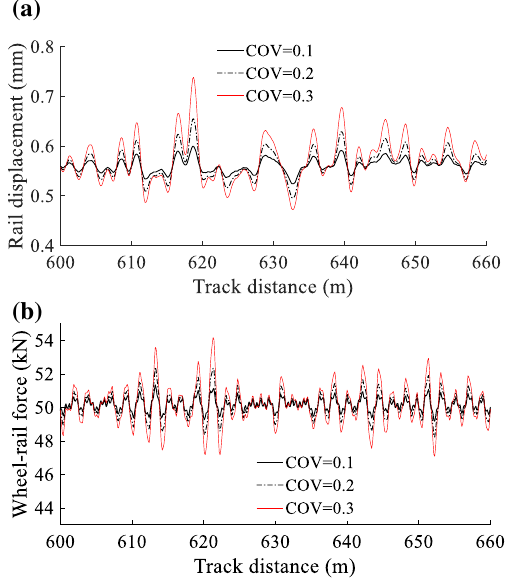
Fig. 13 System responses with respect to spatial variation of track parametric excitations ( a rail displacement; b wheel–rail